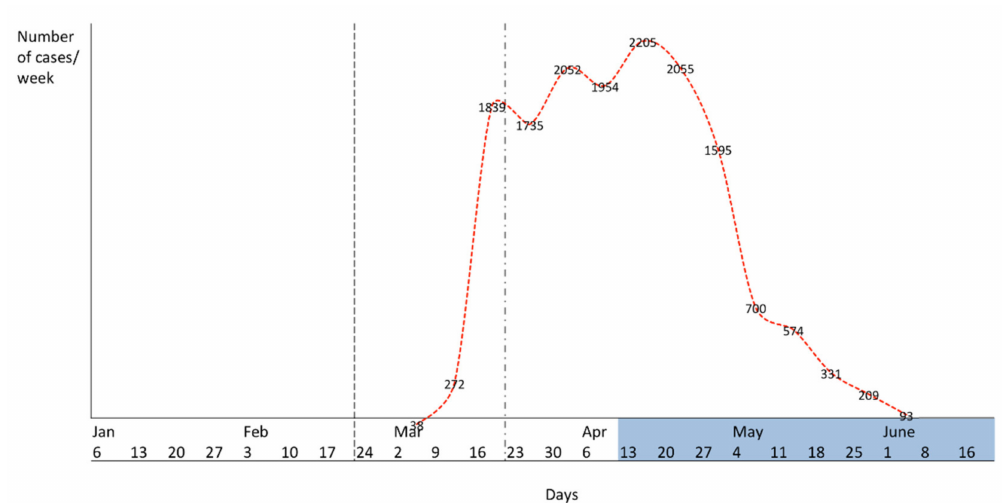
Figure 1. Last menstruation criterion for inclusion and recruitment period. Dotted black line: first reported case of COVID- 19 in Piedmont, Italy; dash-dotted black line: date representing the last menstruation upper limit of inclusion; dotted red line: COVID-19 outbreak cases in Turin, weekly case increase; highlighted blue: recruitment